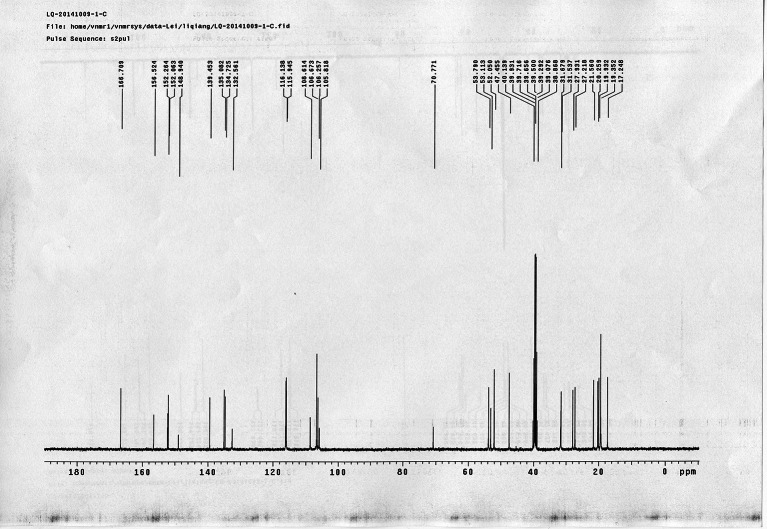
13C NMR spectra of compound 15.